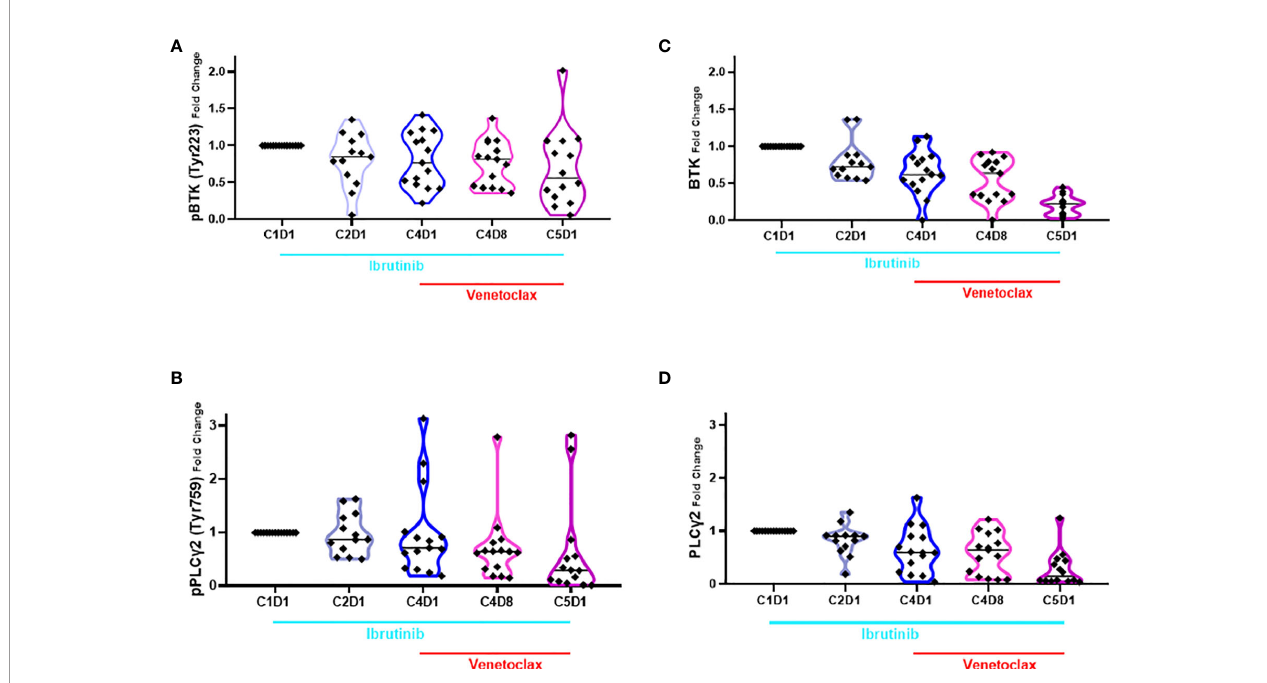
FIGURE 4 | Violin plots for changes in the level of phospho- and total BTK and PLC g 2 proteins during ibrutinib monotherapy or ibrutinib plus venetoclax therapy. PBMCs from 13 to 15 patients were obtained at indicated times during therapy. Proteins were extracted and immunoblots were performed for pBTK (A) , pPLC g 2 (B) ; total BTK (C) and total PLC g 2 (D) . Protein levels were quantitated and normalized with GAPDH and compared with the levels at baseline (C1D1). Each symbol represents a patient sample and horizontal lines are median values. Compared to C1D1 levels, the p-values for pBTK are 0.039, 0.032, 0.005, and 0.023 at C2D1, C4D1, C4D8, and C5D1. Compared to C1D1 levels, the p-values for pPLC g 2 are 0.418, 0.479, 0.048, and 0.072 at C2D1, C4D1, C4D8, and C5D1. Compared to C1D1 levels, the p-values for total BTK are 0.0113, 0.0002, <0.0001, and <0.0001 at C2D1, C4D1, C4D8, and C5D1. Compared to C1D1 levels, the p-values for total PLC g 2 are 0.0262, 0.0033, 0.0004, and <0.0001 at C2D1, C4D1, C4D8, and C5D1. C, cycle and D,